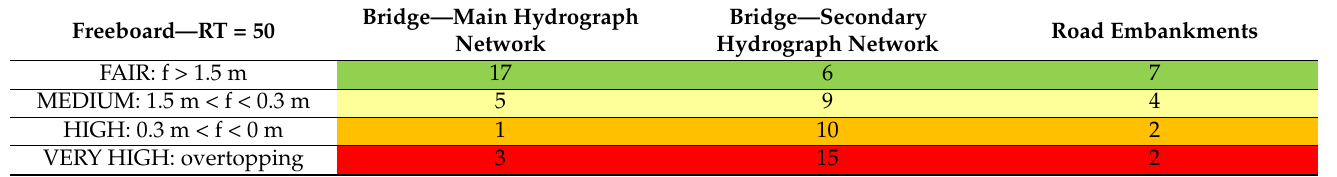
Table A1. Vulnerability levels referring to the freeboard for bridges and road embankments, RT = 50.